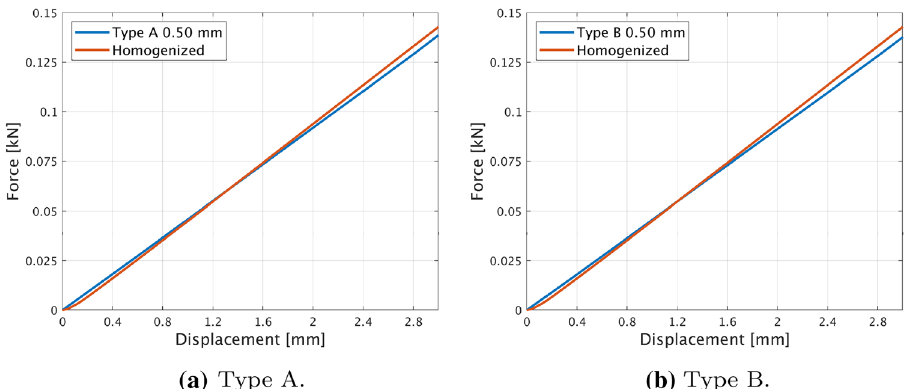
Fig. 12 A comparison is made between the detailed models and the homogenized